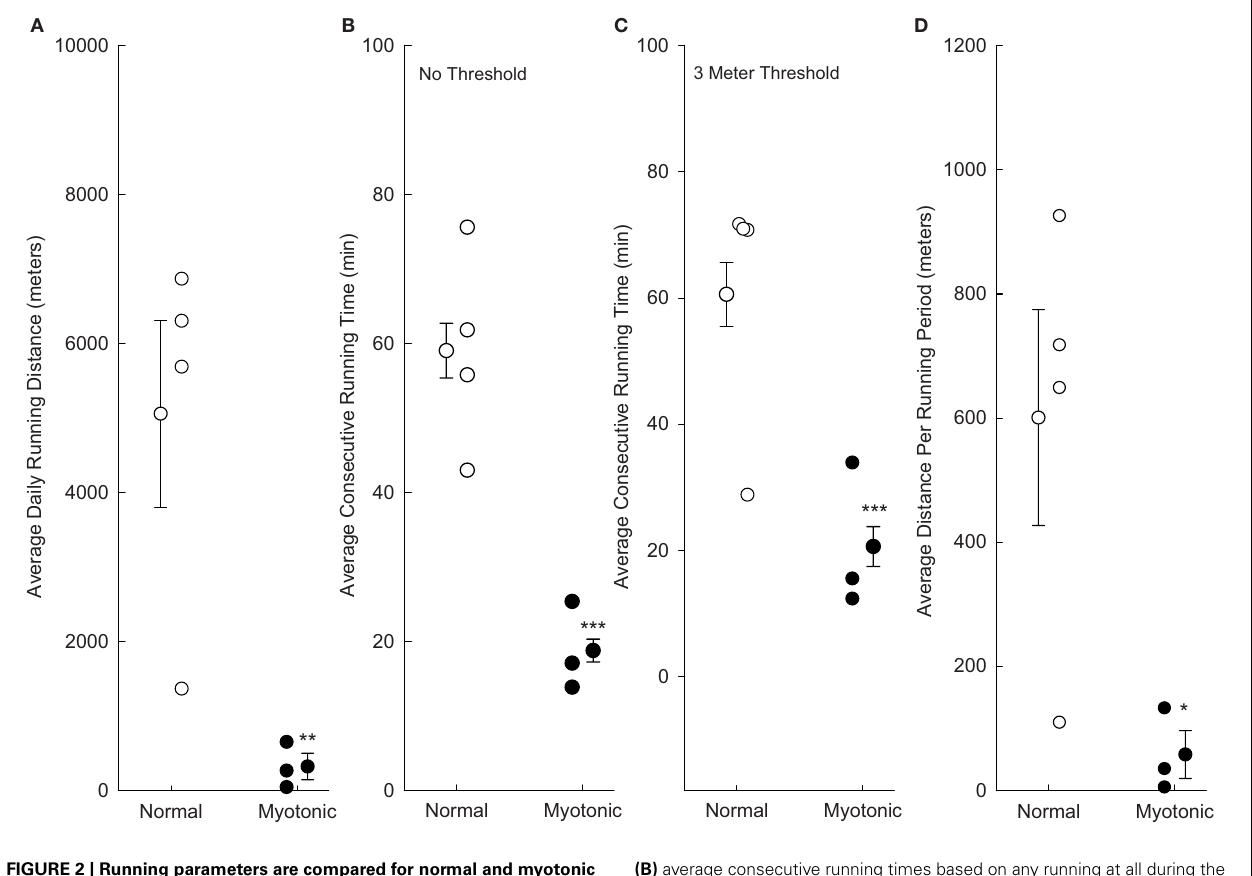
(B) average consecutive running times based on any running at all during the 10min period; (C) average consecutive running times quantified based on the animals having to have run at least 3m during the 10min period to be considered as having run; (D) average consecutive running distances based on any running during the 10-min